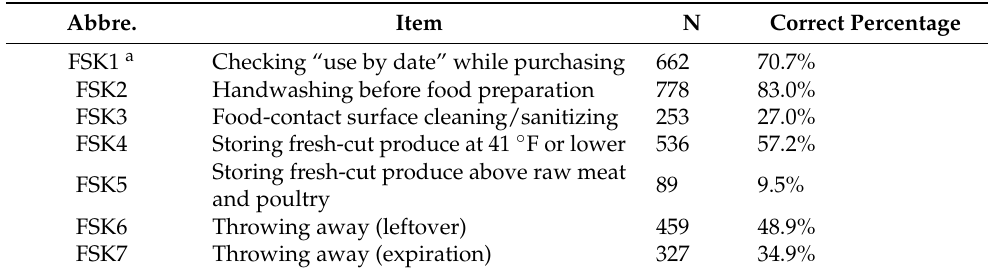
Table 2. Descriptive analysis of food safety knowledge associated with fresh-cut